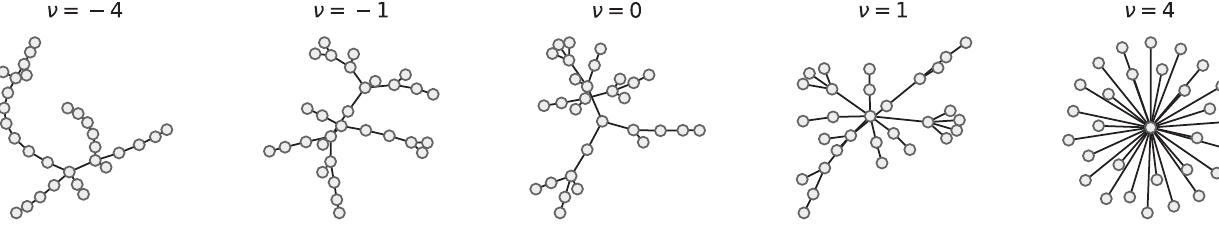
FIG. 6. Network instances produced using the generalized preferential attachment model. The model tends to generate chainlike networks for negative values of ν and star networks for positive values. The figure was inspired by Ref.